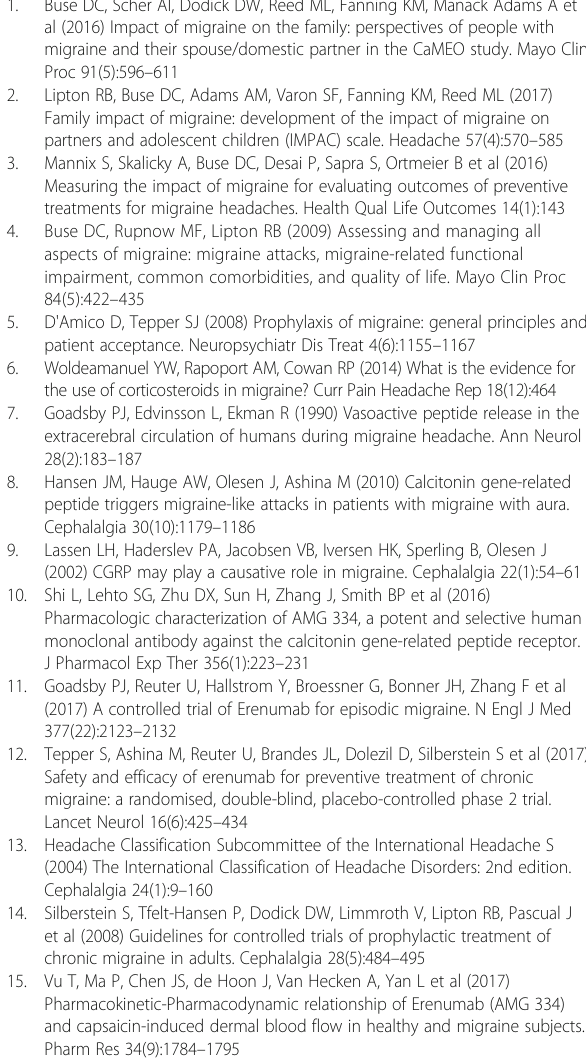
Abbreviations CGRP: Calcitonin gene-related peptide; CI: Confidence interval; CM: Chronic migraine; EM: Episodic migraine; ICHD-3: International Classification